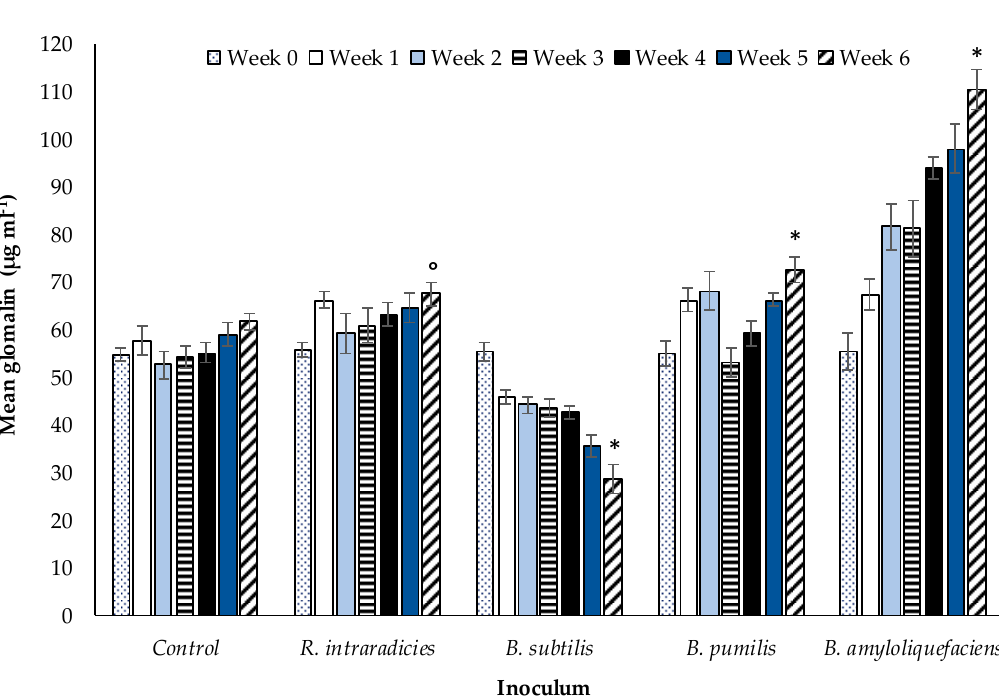
Figure 7. Mean (n = 175 overall) glomalin concentration (µg mL − 1 ) comparing inoculated and a non-inoculated control sandy loam top soil ( < 10 cm) extracted from a ZT managed field over a six week period under controlled glasshouse conditions. TRUE Bonferroni corrections (*), FLASE Bonferroni corrections ( ◦ ). Error bars = one SEM. Microorganisms 2020 , 8 , x FOR PEER REVIEW